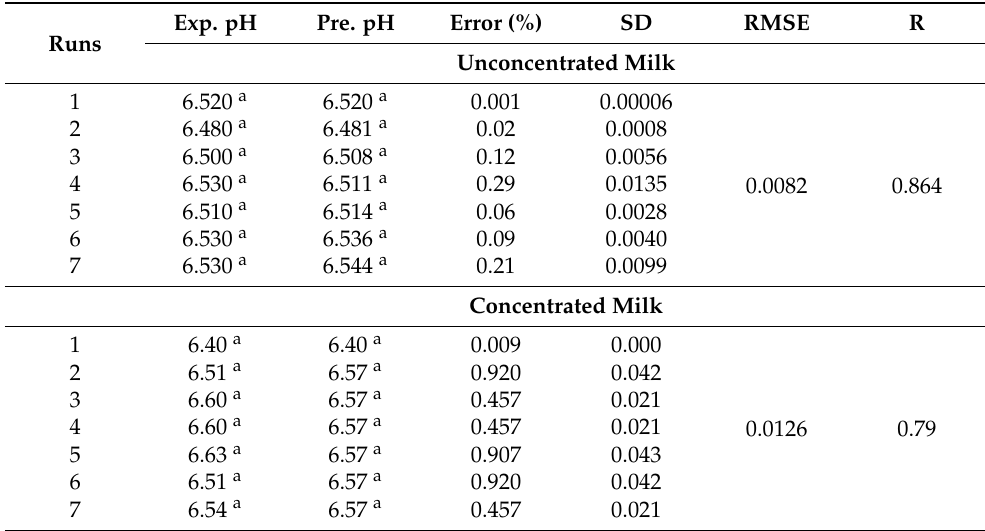
Table 3. Statistical parameters of experimental and predicted unconcentrated and concentrated milk pH values affected by color components.